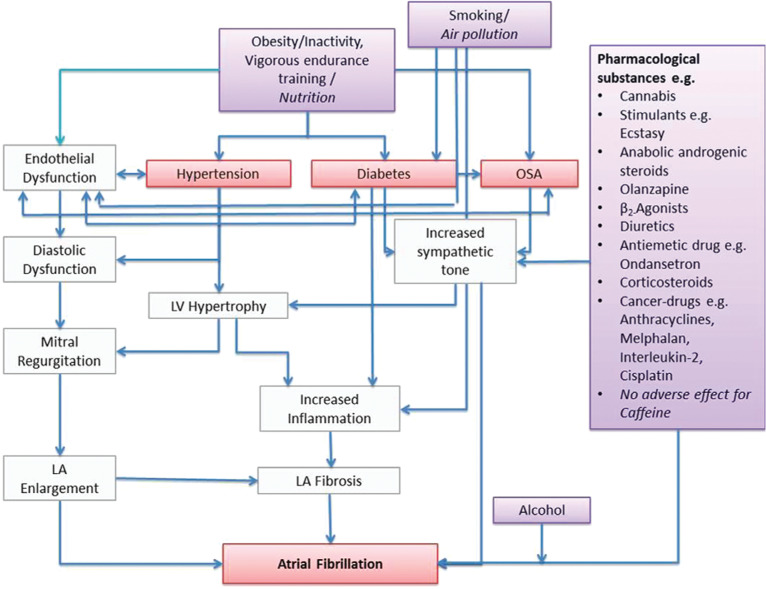
Risk factors, triggers, and cardiovascular conditions contributing to the development of AF. Reproduced with permission from: Gorenek B, Pelliccia A, Benjamin EJ, et al. European Heart Rhythm Association (EHRA)/European Association of Cardiovascular Prevention and Rehabilitation (EACPR) position paper on how to prevent atrial fibrillation endorsed by the Heart Rhythm Society (HRS) and Asia Pacific Heart Rhythm Society (APHRS). Europace. 2017;19(2):190–225.